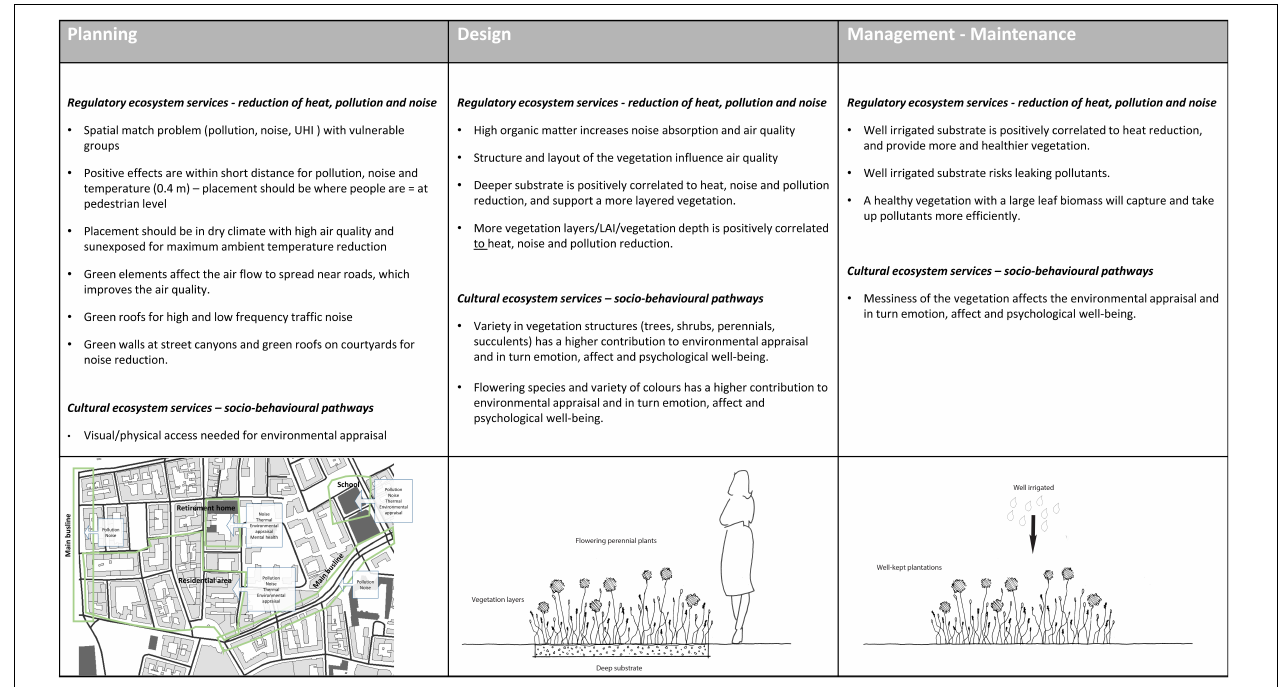
FIGURE 2 | Guidelines for optimizing the effect of green walls and green roofs in delivering public health-supporting ecosystem services.